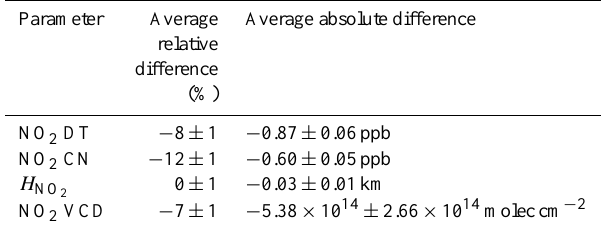
), and vertical column density (VCD) dur- acteristic height ( H NO 2 ing the hours of 12:00–14:00EST as a result of NO z interference